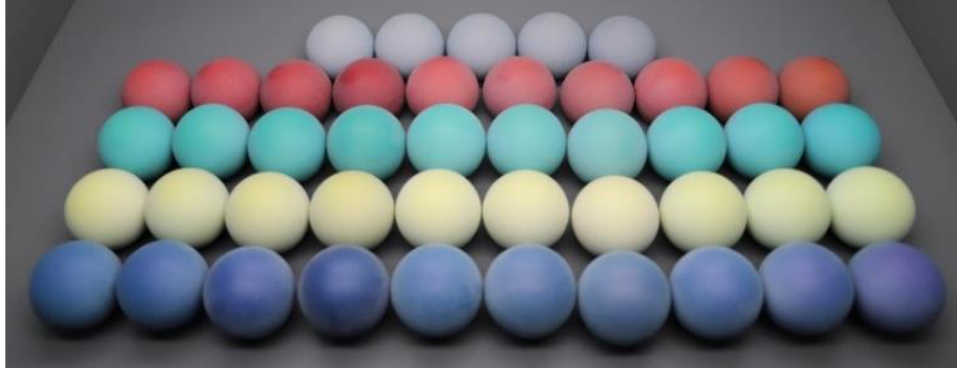
Figure 1. The 45 spherical samples printed using the Stratasys J750 3D color printer. Each sample was measured at three different points using a Konica Minolta CM-700d spectrophotometer with d:8 geometry, small aperture (SAV 3 mm), and specular component-included (SCI) mode. The measured spectral reflectance data were used to calculate the corresponding CIELAB values using the CIE 1964 standard observer under the illumination used in this study. The average measurement results of each sample are shown in 𝐿 10∗ 𝐶 𝑎𝑏,10∗ and 𝑎 10∗ 𝑏 10∗ diagrams in Figure 2, where the triangle symbols are approximately positioned at the ‘centers of gravity’ of the 5–10 printed samples at each of the five CIE-recommended centers, gray, red, green, yellow and blue (Figure 1), and they represent the five samples that were considered as reference samples in Experiment II. To quantify the color homogeneity of the 3D-printed samples, the mean color difference from the mean ( MCDM ) of the CIELAB units was calculated from the results of the three measurements [17]. The measured average MCDM value of the 45 samples was 1.77 units, which demonstrates relatively good color uniformity using 3D printing technology [22].